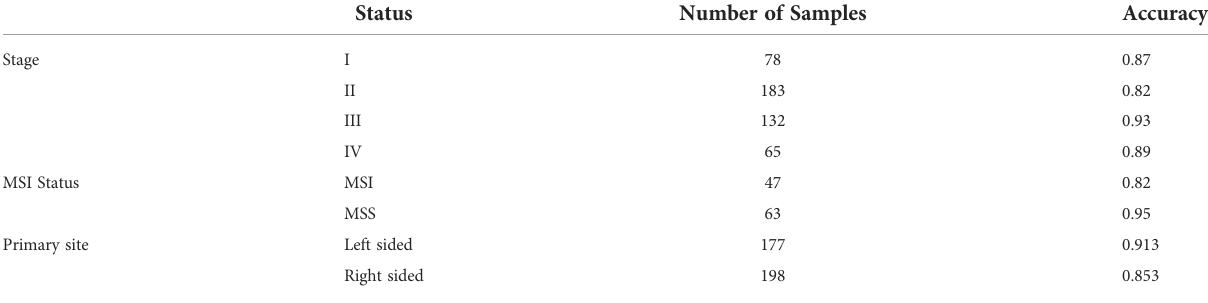
TABLE 5 Performance of the lncRNA pair biomarkers in different stages, the microsatellite instability status, and the site of CRC in the TCGA dataset.